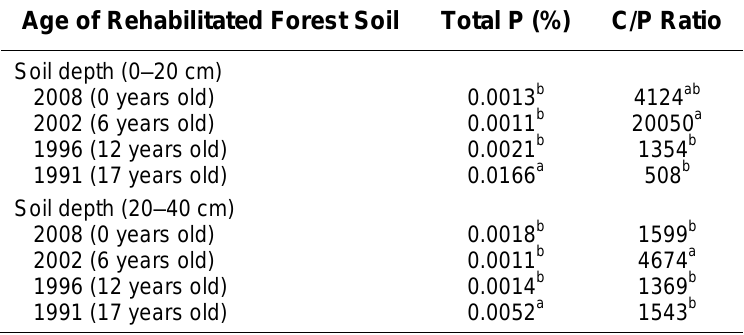
Total P and C/P Ratios of a Rehabilitated Forest Soil (Different Ages) Age of Rehabilitated Forest